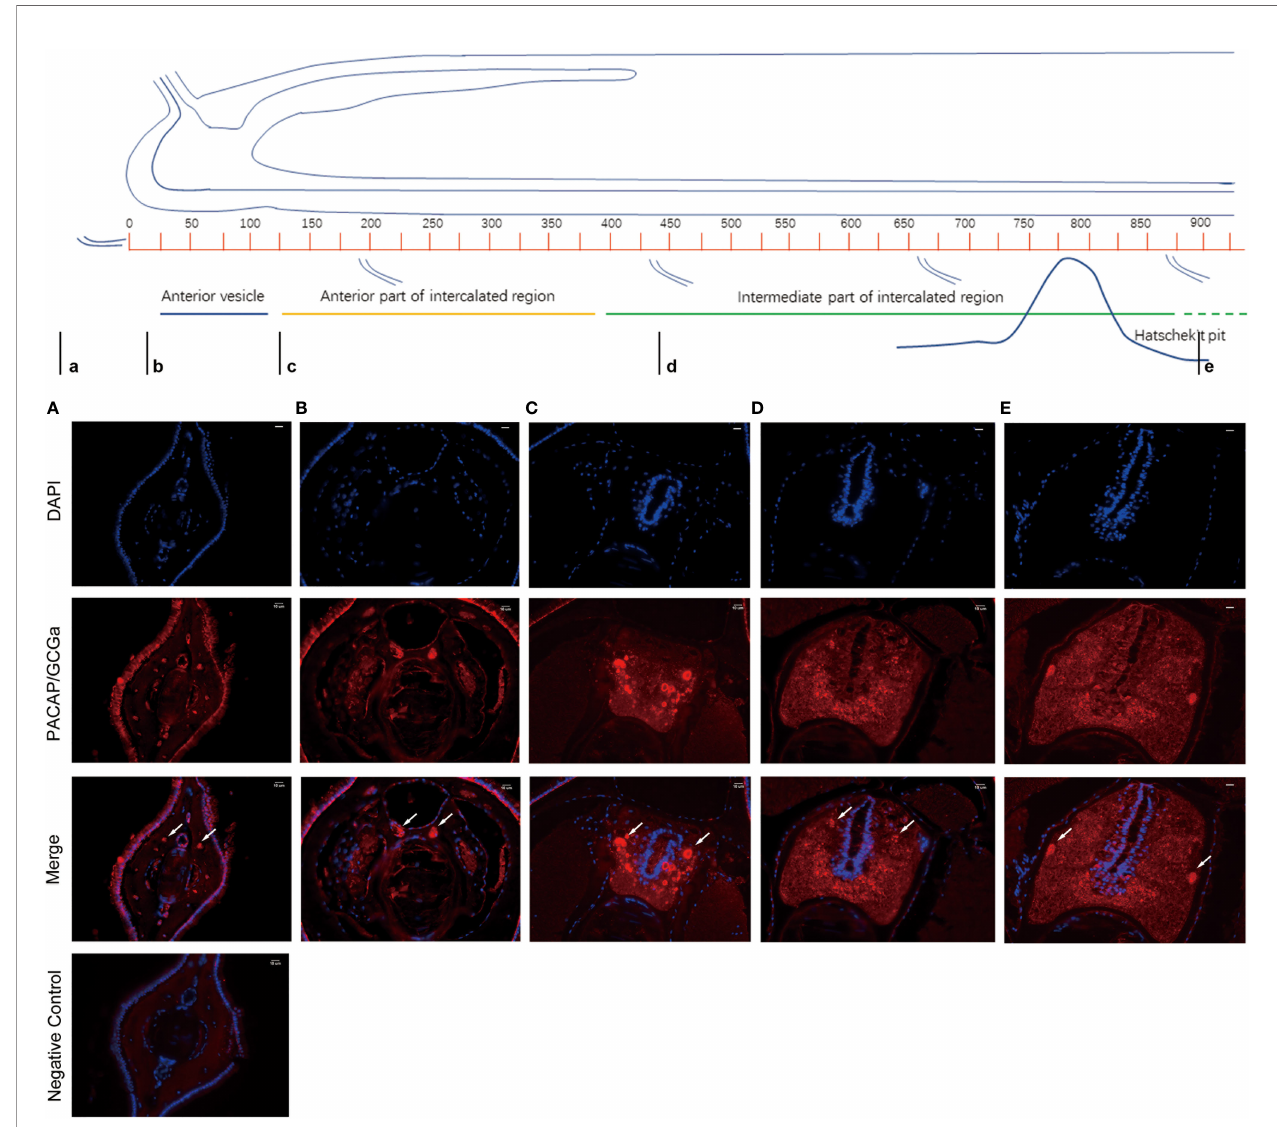
FIGURE 5 | Detection of PACAP/GCGa in B . belcheri by immuno fl uorescence staining in the anterior nerve cord. The anterior brain of an adult amphioxus is represented on the top [adapted from Castro et al. 2015 (33)]. The small letters below the image indicate the location of the transversion sections analyzed (A – E) . Immuno fl uorescence staining digital images of DAPI (blue) and PACAP/GCGa (red) and the merged anterior nerve cord region sections. The white arrows indicate the condensed points of antibody positive signal against PACAP/GCGa in B . belcheri neurons. The scale bar is 10 m m and is indicated in the fi